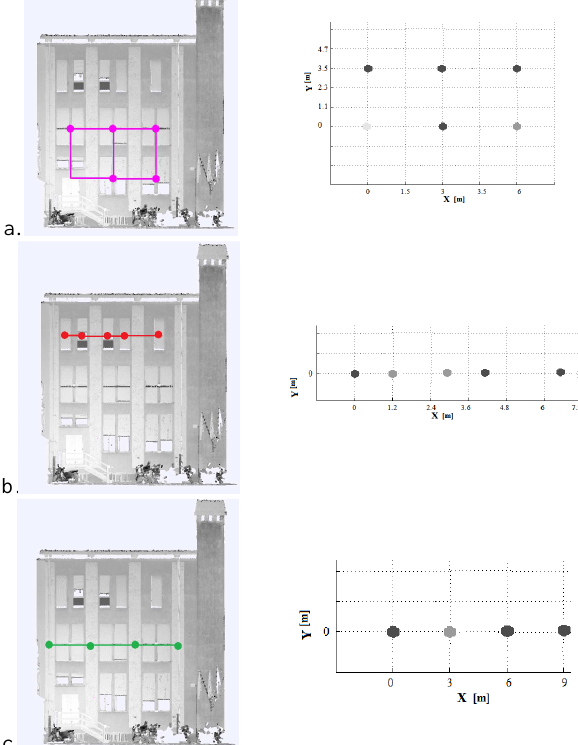
Figure 7. Regularity structure superimposed to the point cloud (left) and lattice estimation (right). Lattices centres are coloured according to the associated weight (white for 0 and black for